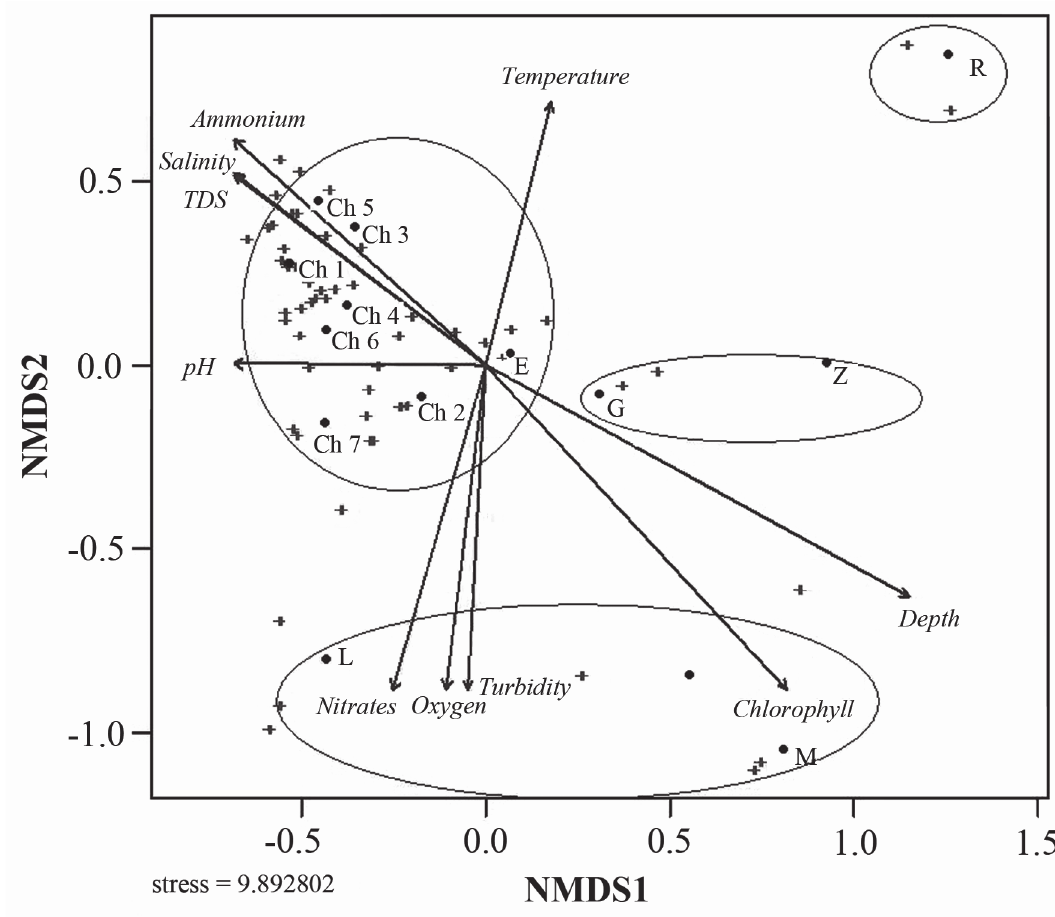
Fig. 4. n-MDS (non-metric Multi-Dimensional Scaling, Bottom) whit the effect of environmental variables during the annual cycle on the sites of Chacmochuch Lagoon System whit p-values of the total fish species (size of the line, determines the effect of variable. Circle diameters are sized in proportion to the variables effect in each site). For the analysis square root transformation was used and stepping across of 78